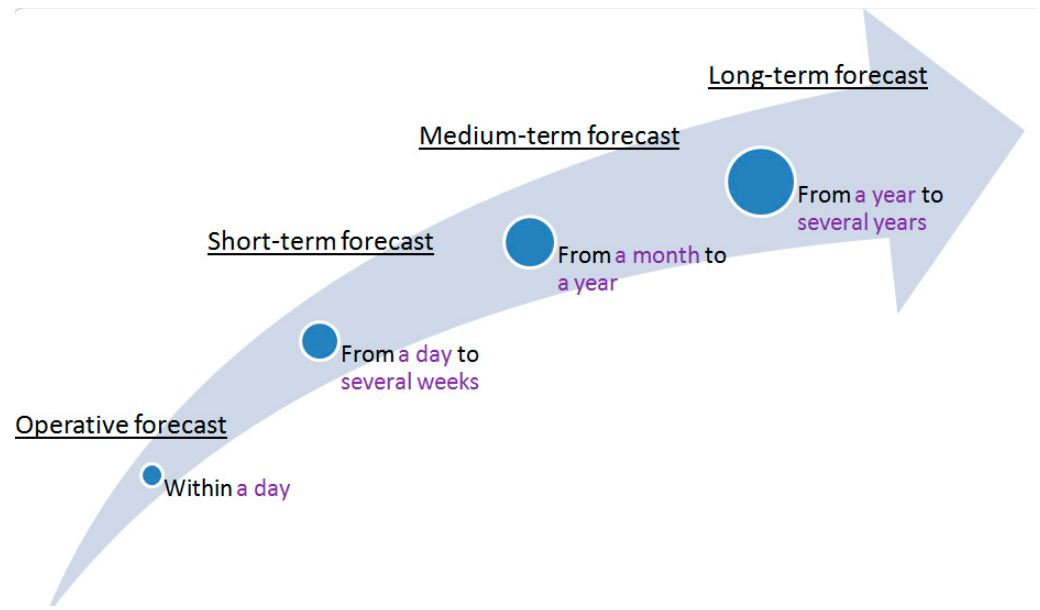
Figure 3. Classification of forecasts by lead time.